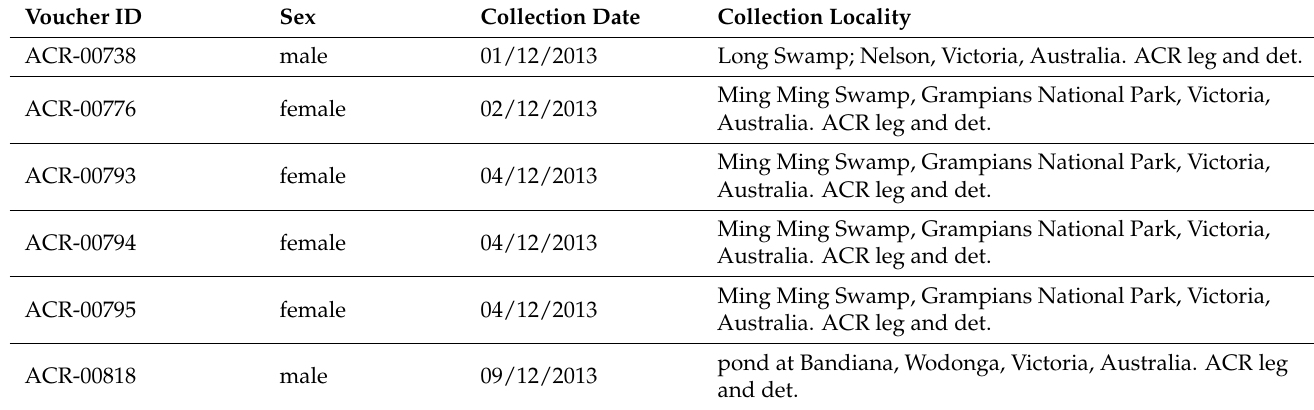
Table A2. List of Ischnura aurora material belonging to Adolfo Cordero-Rivera’s personal collection used for morphological examination (see main text). Listed are the voucher ID, sex and collection details for each specimen. Collector’s names are as follows: Adolfo Cordero-Rivera (ACR), Iago Sanmart í n-Villar (ISV) and Haomiao Zhang